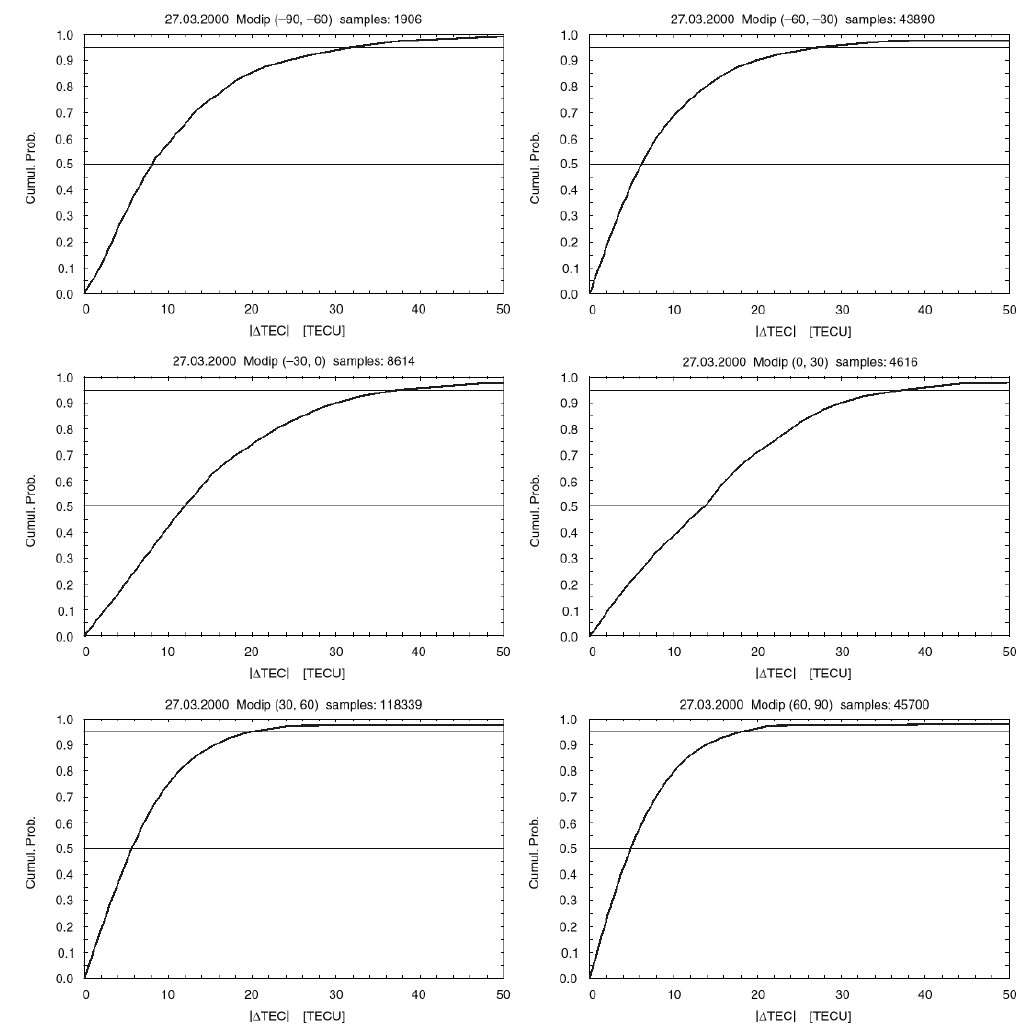
Fig. 2. Cumulative distributions of the absolute values of the differences between experimental and recon- structed slant TEC data for stations lying in different Modip intervals. The statistics are computed using slant TEC data at 5 min time intervals for the day 27 March